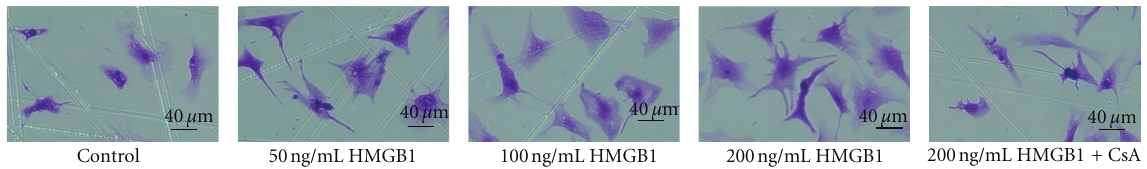
Figure 4: The cellular morphology change of NRVMs was observed using inverted microscopy.